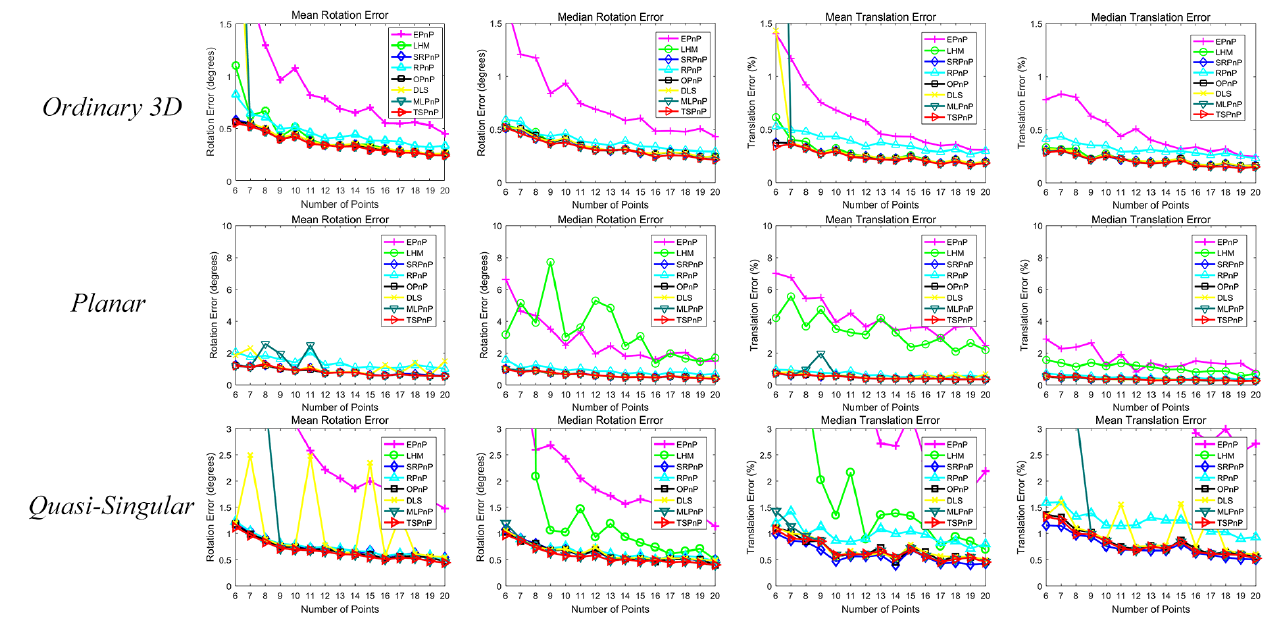
Figure 7. The rotation and translation errors under different number of